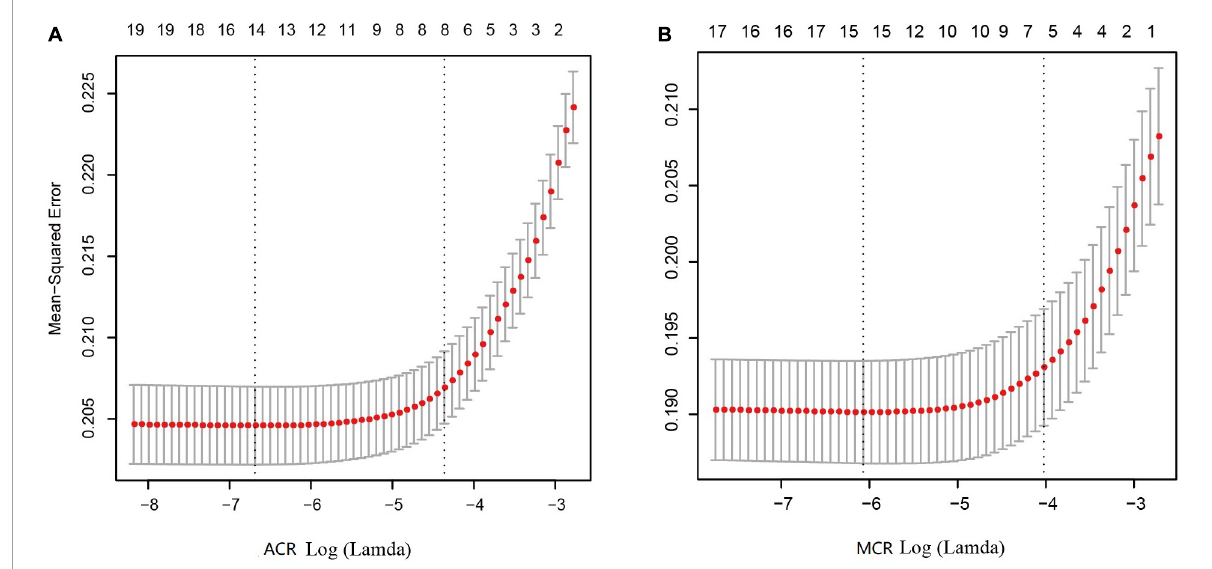
FIGURE3 Results of feature selection using LASSO. When Lamda is minimum, corresponding features were taken into model construction, that is, 14 features for ACR outcomes (A) and 15 feature for MCR outcomes (B) .